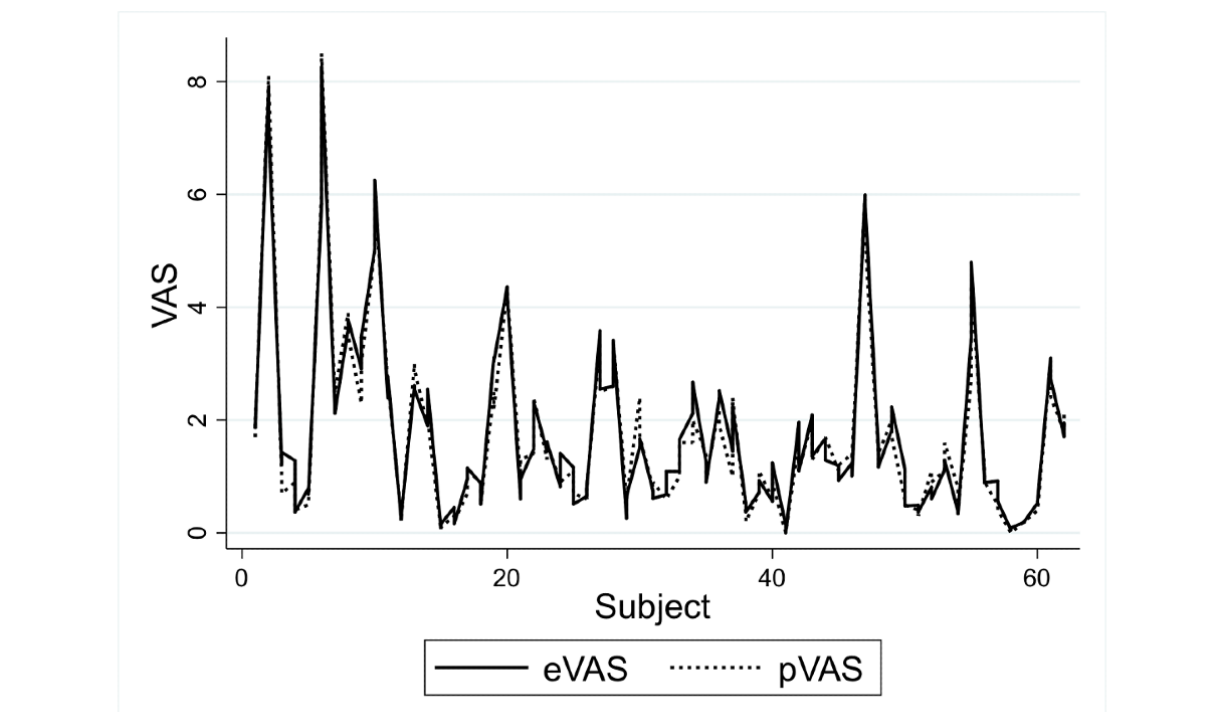
Figure 8. Rating data for the two methods in adults. eVAS: electronic visual analog scale; pVAS: paper visual analog